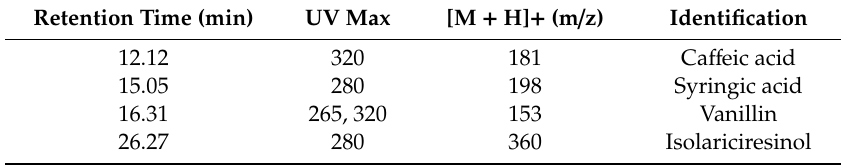
Table 1. Phenolic compounds identification in cold-pressed pumpkin seed oil by HPLC-MS.